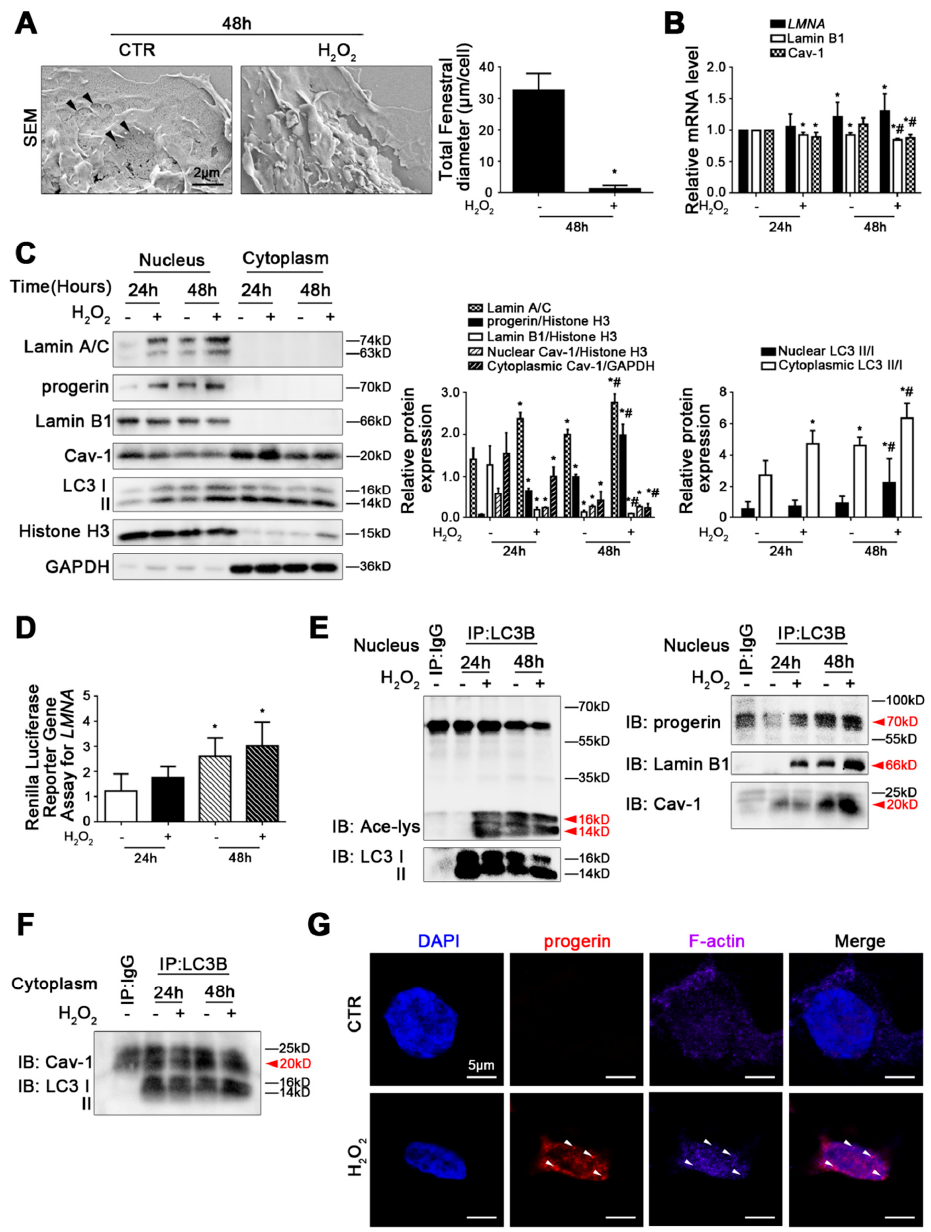
Figure 4. H 2 O 2 induces excessive accumulation of progeirn, with depletion of Lamin B1 and Cav-1 to aggravate LSEC defenestration. Fresh rat primary LSECs, isolated from normal male SD rats, were treated with H 2 O 2 (10 μ M) in vitro for 48 h. ( A ) The magnification of SEM for fenestrae in primary LSECs in 48 h (scale bar: 2 μ m). The black triangles indicate fenestrae in LSECs. The total fenestral diameter is quantified in the graph (right). * p < 0.05 versus the control group in 48 h. ( B ) RT − qPCR analysis for mRNA levels of LMNA , Lamin B1, and Cav-1 of primary LSECs in 24 h and 48 h. * p < 0.05 versus the control group in 24 h; # p < 0.05 versus the control group in 48 h. ( C ) Representative immunoblots of Lamin A/C, progerin, Lamin B1, Cav-1, and LC3 II/I in nucleus and cytoplasm of primary LSECs in 24 h and 48 h. The relative protein expression and LC3 II/I expres- sion in nucleus and cytoplasm are quantified in the two graphs (right). * p < 0.05 versus the control